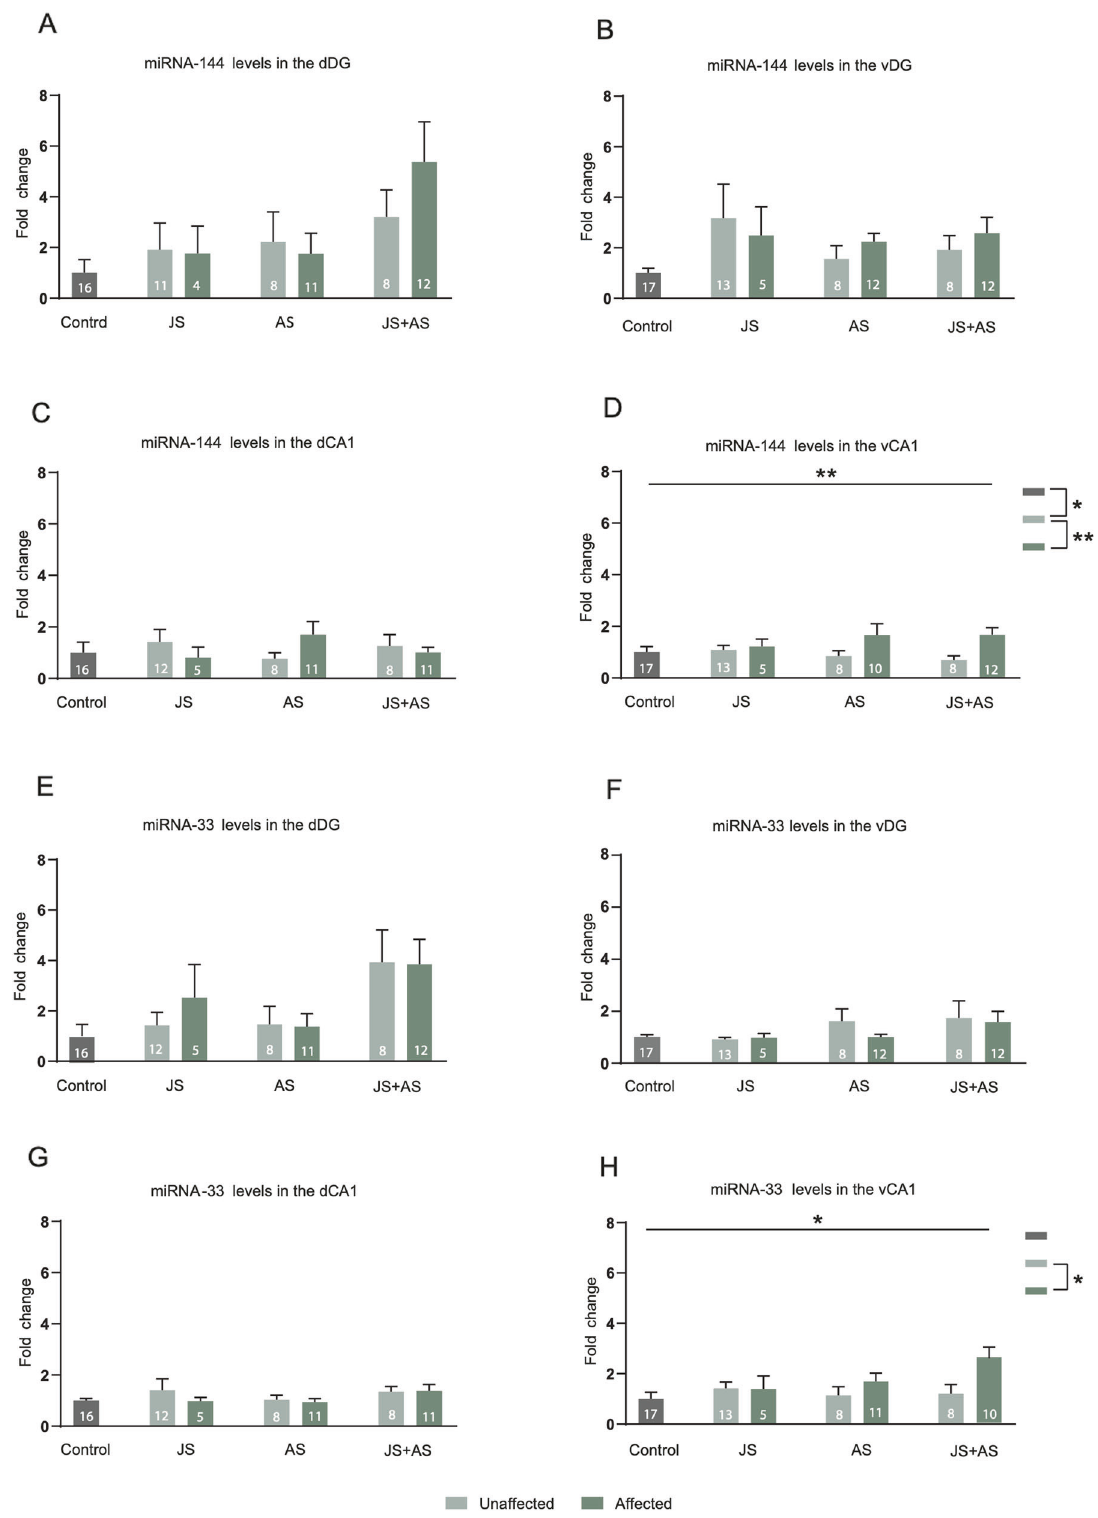
Fig. 4 miRNA levels in affected and unaffected female rats. A – C No main effects or interactions were observed in miRNA-144 levels in the dDG, vDG and dCA1. D Increased miRNA-144 levels occurred speci fi cally in the vCA1 of affected compared to unaffected rats. E – G No main effects or interactions were observed in miRNA-33 levels in the dDG, vDG and dCA1. H Within the vCA1 increased miRNA-33 levels occurred in stress affected compared to those in unaffected rats. Data presented as means and standard errors of fold-change relative to control. *Signi fi cant difference between pro fi les, p <